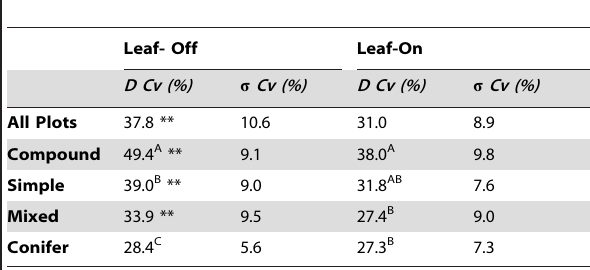
Table 7. Average coefficient of variation ( Cv ) values and associated standard deviation of mean Cv for non-ground leaf-off and leaf-on lidar data within all plots and plots stratified by vegetation